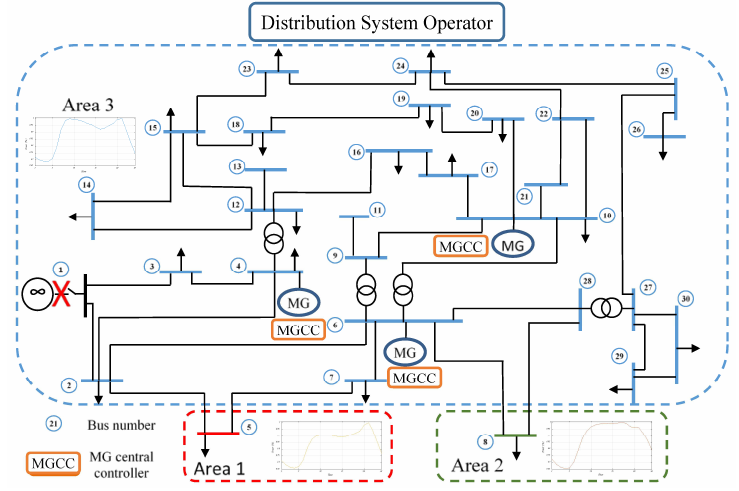
Figure 1. Modified IEEE 30 bus system.